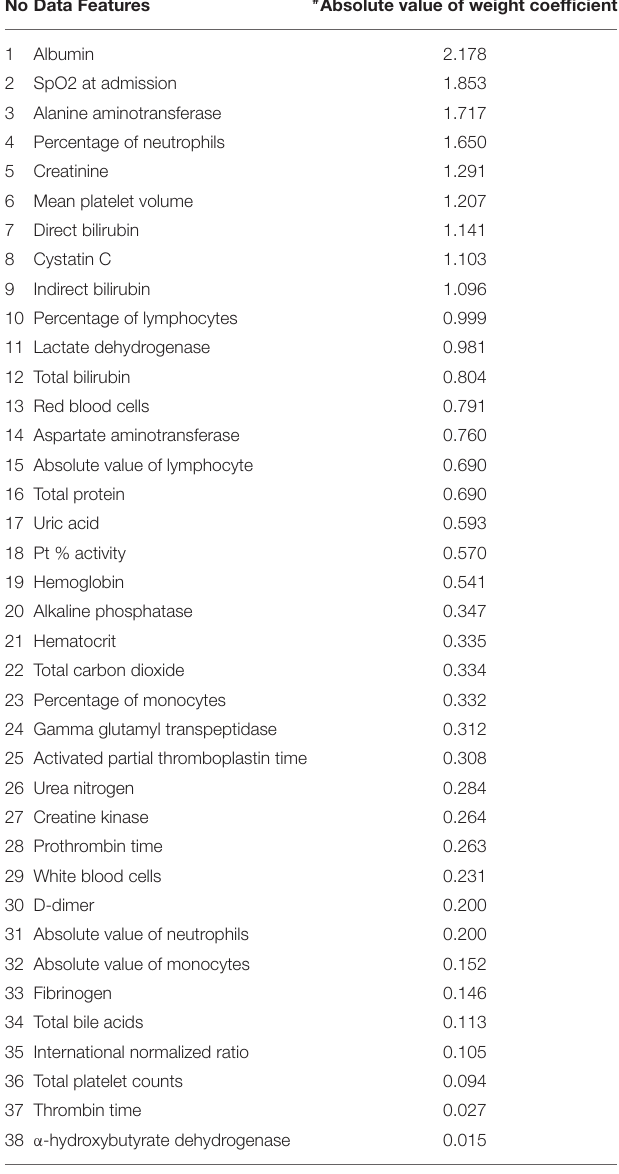
TABLE 1 | The scores of training model based on laboratory measurements of COVID-19 patients in Leishenshan Hospital, China. # No